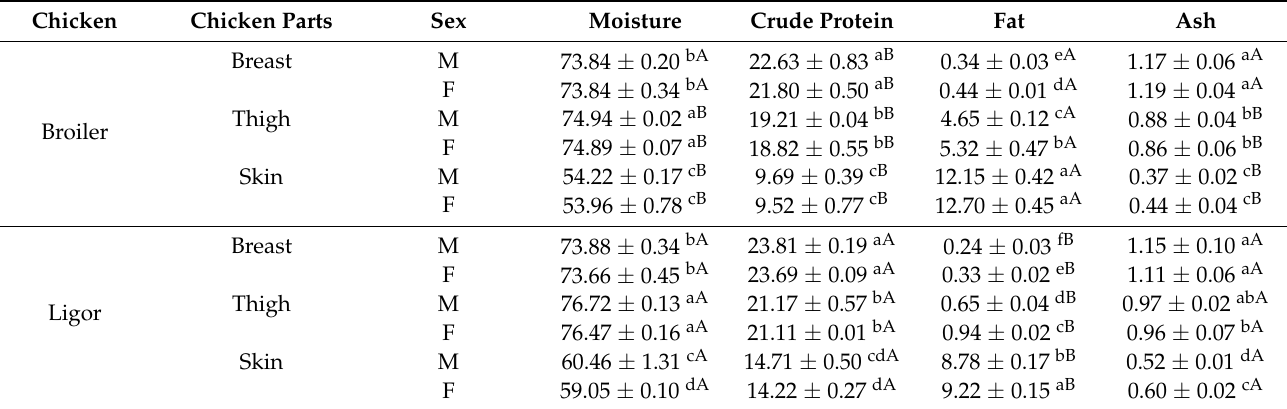
Table 1. Proximate composition (%, wet basis) of breast, thigh, and skin of broiler and Ligor hybrid chicken from different